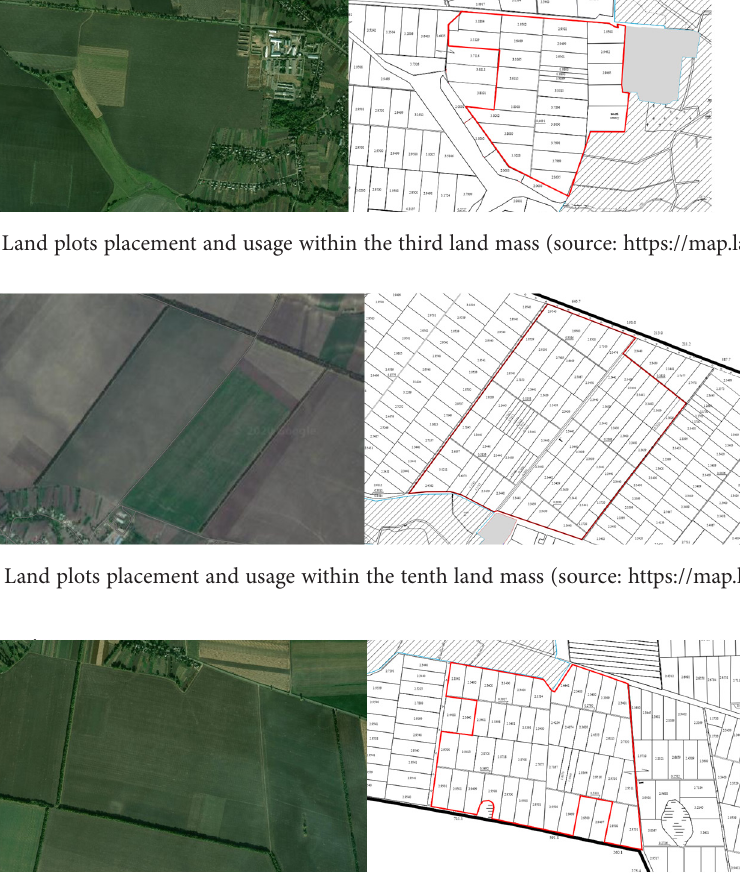
Figure 9. Land plots placement and usage within the sixth land mass (source: